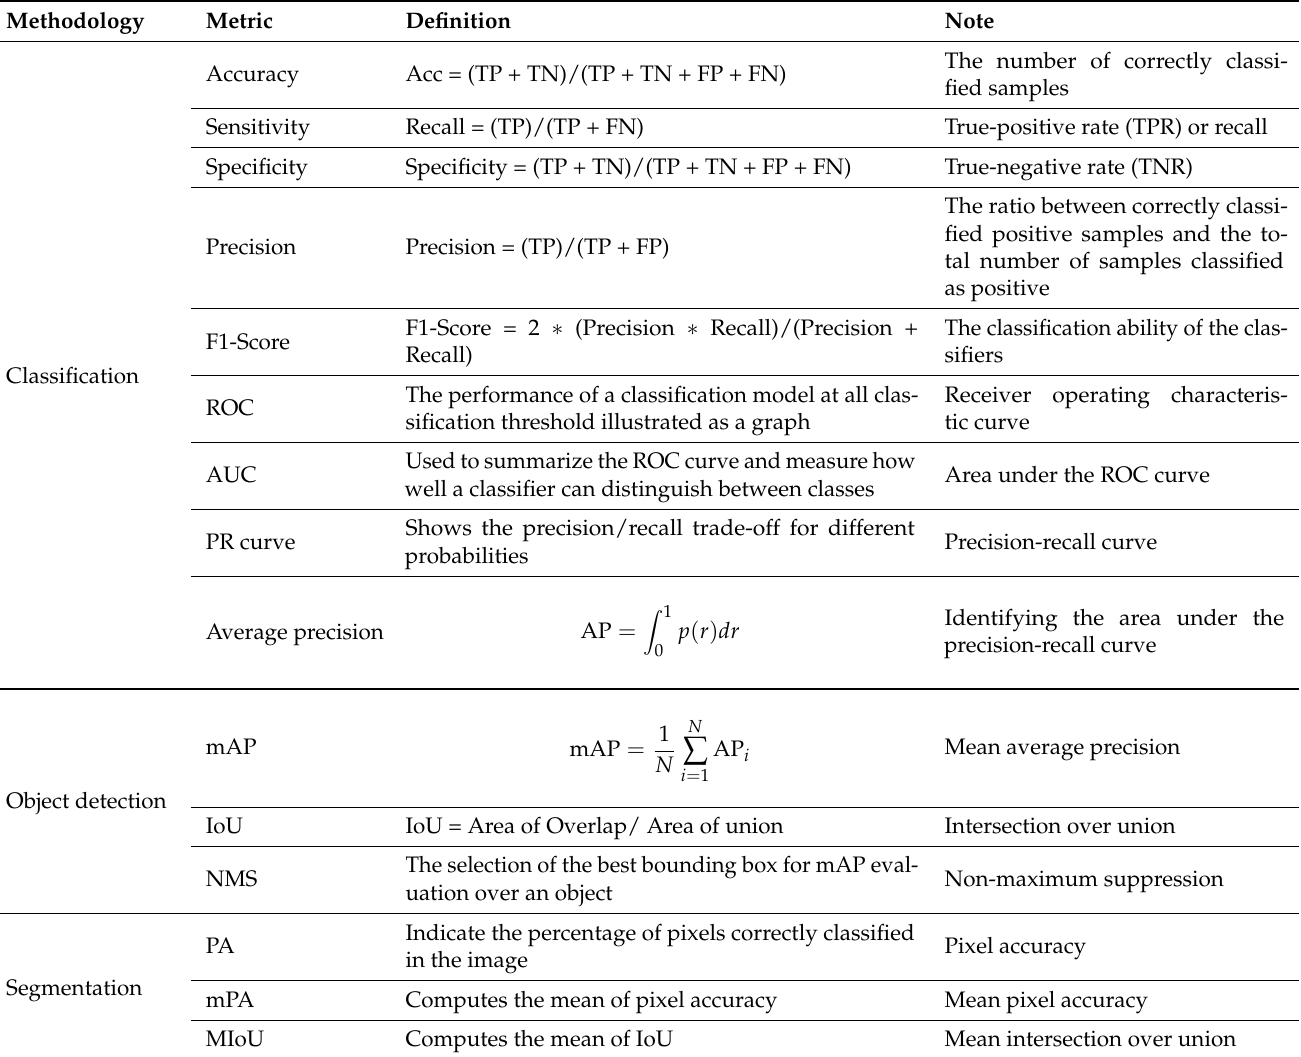
Table 1. Metrics used in deep learning for breast cancer detection. TP = true positive, TN = true negative, FP = false positive and FN = false